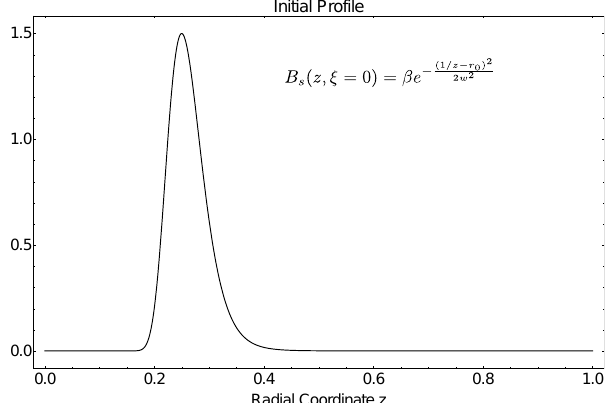
Figure 2 . Initial Gaussian \Pulse" B s ( z ) is displayed in terms of the inverted coordinate z = 1 =r . Parameters take the values w = 0 : 5, r 0 = 4 and (cid:12) = 1 : 5.